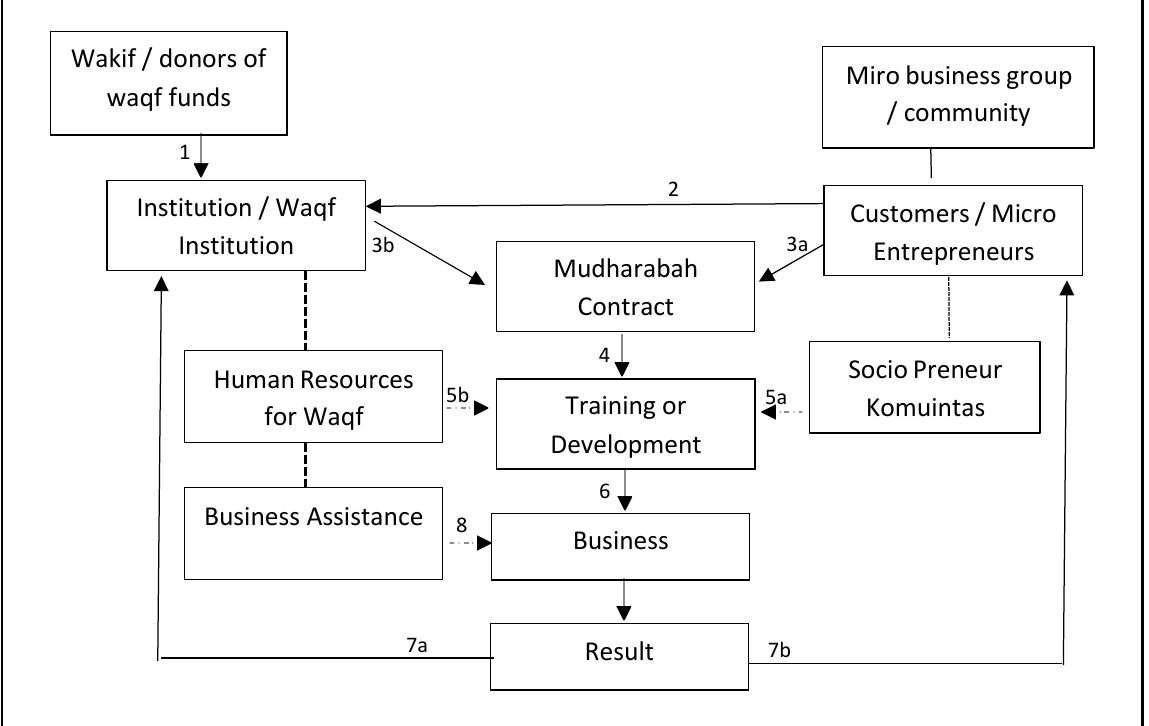
Figure 3: Development of a Micro Business Empowerment Model Through Cash